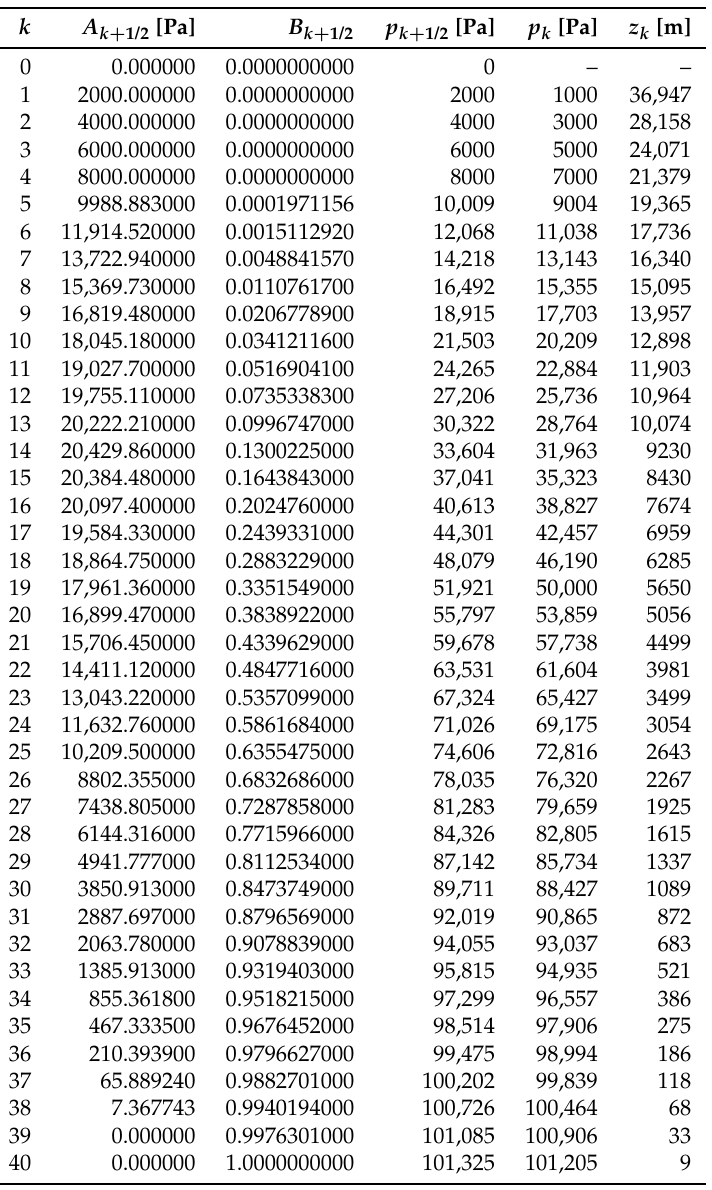
Table A1. Vertical-coordinate parameters ( A k + 1/2 ; B k + 1/2 ) of HIRHAM’s 40-layer version as used in HN2.0. The associated half- and full-level pressures ( p k + 1/2 ; p k ) and geometric heights ( z k ) apply to a surface pressure p s =101,325Pa and a scale height H